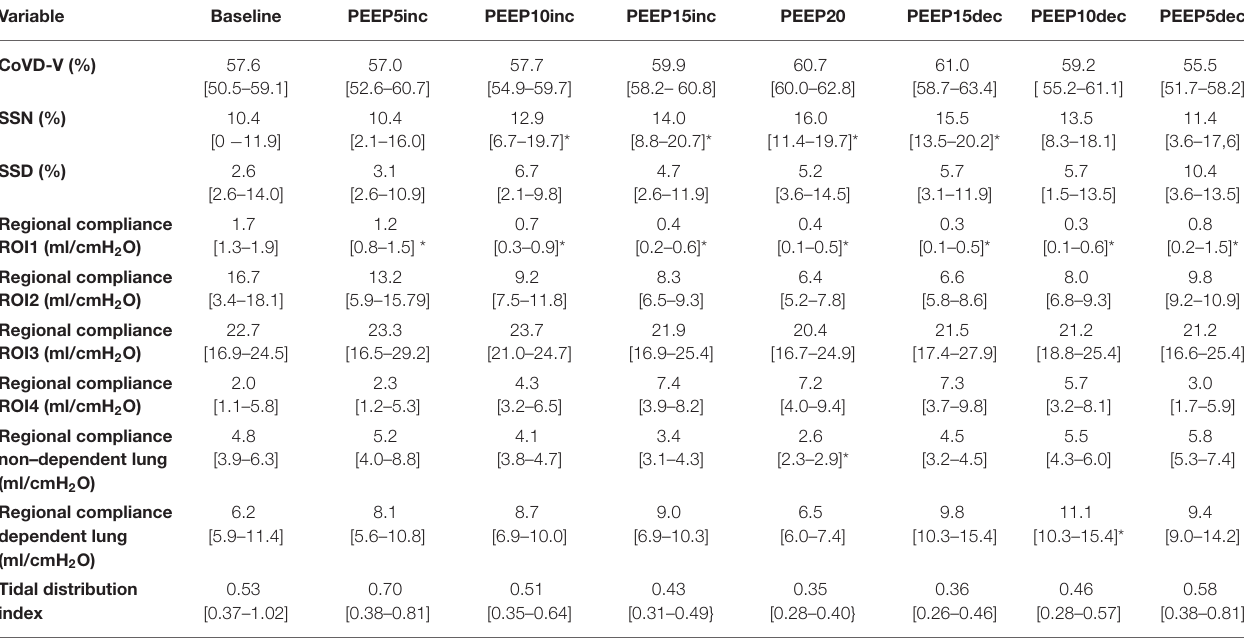
TABLE 1 | Electrical impedance tomography data.